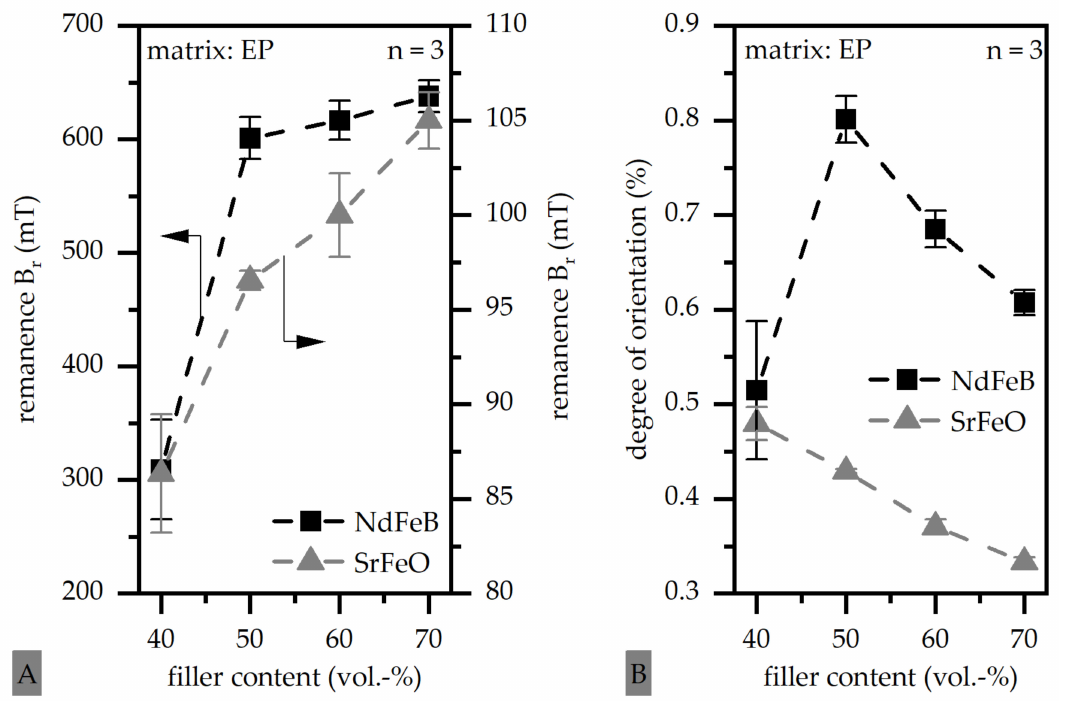
Figure 7. Magnetic properties ( A ) and degree of orientation ( B ) of thermoset-based compounds before the recycling